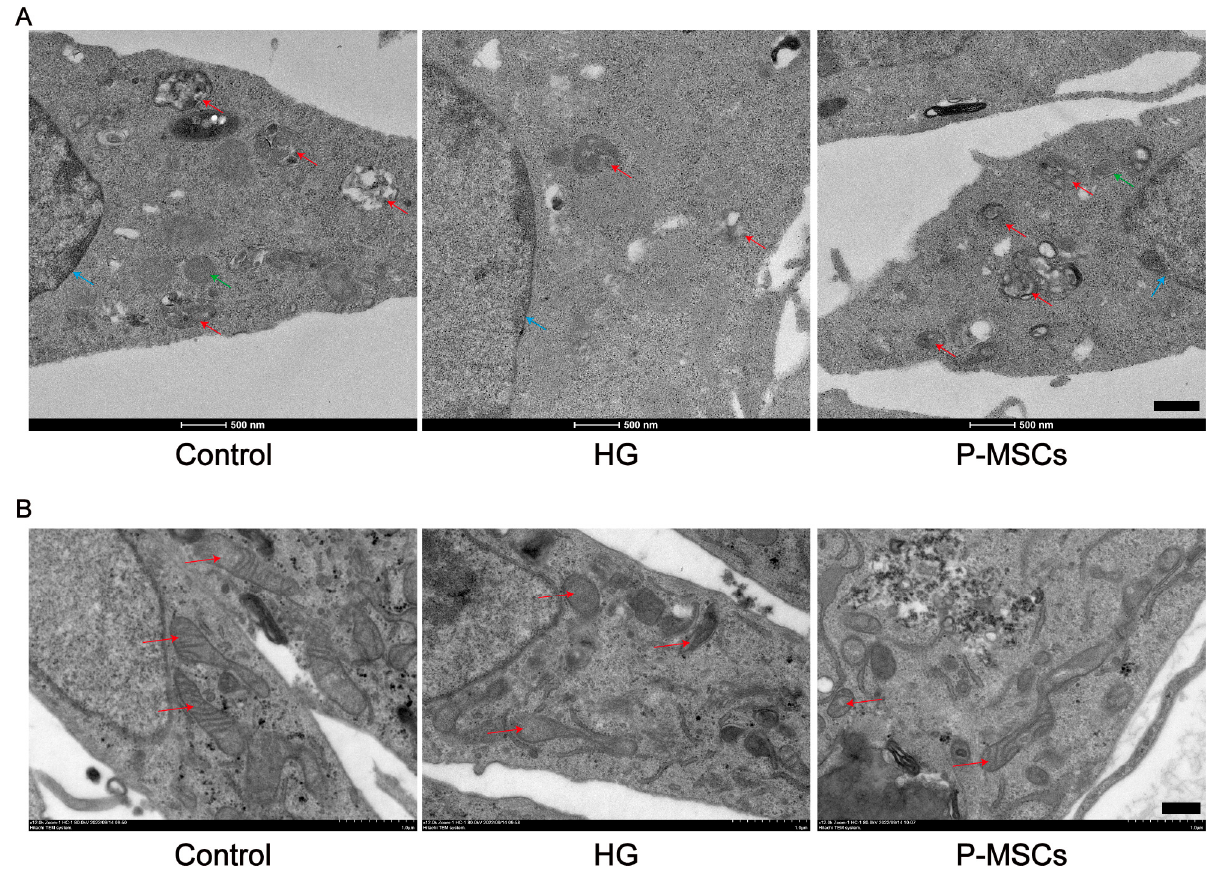
Figure 3. Transmission electron microscopy analysis of autophagosomes and mitochondria. ( A ) The integrity of the nuclear membrane was disrupted (blue arrows) accompanied by fewer autophago- somes (red arrows) and lysosomes (green arrows) in the HG group compared with the control group. P-MSCs reduced nuclear damage and increased autophagosomes and lysosomes. ( B ) Mitochondria were columnar or reticular, with clear mitochondrial cristae, normal matrix density, and intact mitochondrial membranes in the control group. Mitochondrial structures were significantly damaged in the HG group. P-MSCs improved the structures of mitochondria. Scale bars: 500 nm for ( A , B ).